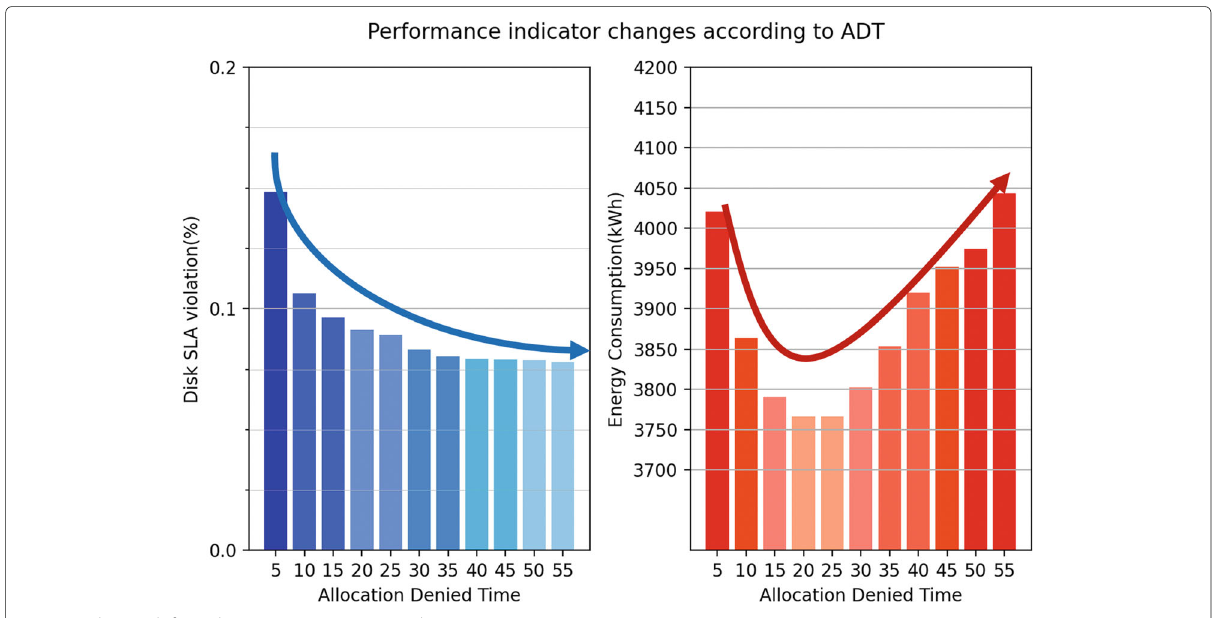
Fig. 7 Disk SLAV(left) and Energy consumption(right)